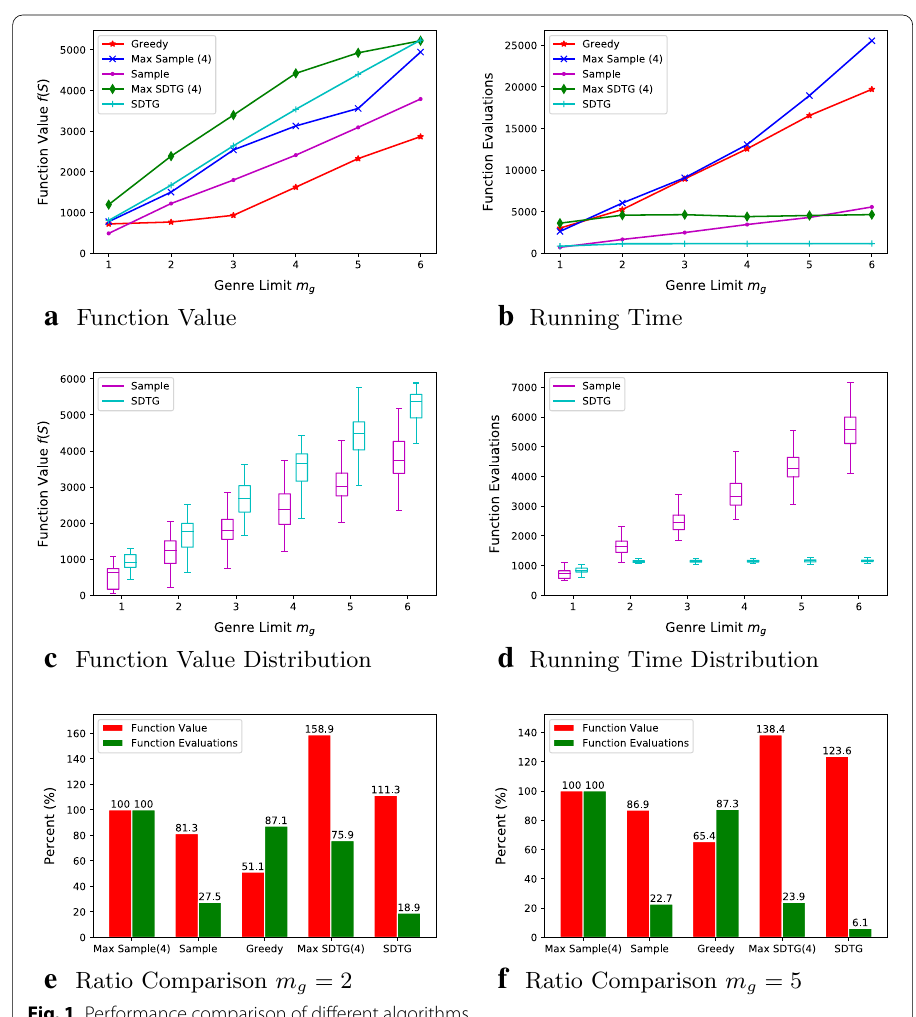
Fig. 1 Performance comparison of different